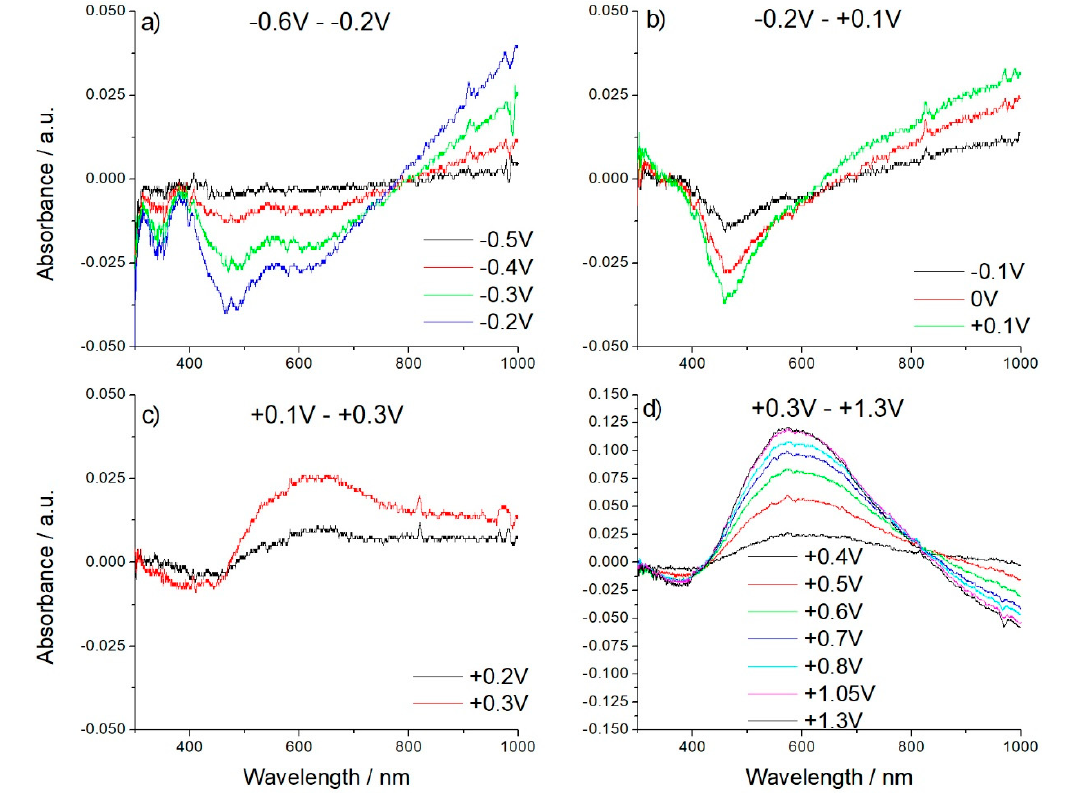
Figure 7. UV-vis-NIR spectra of a poly-[Co(Amben)]-modified ITO-coated glass electrode acquired during redox switching in 0.1 M Et 4 NBF 4 /EC/DEC: ( a ) spectra collected from − 0.6 to − 0.2 V, referenced to the spectrum of the polymer at − 0.6 V, ( b ) spectra collected from − 0.2 to +0.1 V, referenced to the spectrum of the polymer at − 0.2 V, ( c ) spectra collected from +0.1 to +0.3 V, referenced to the spectrum of the polymer at +0.1 V, ( d ) spectra collected from +0.3 to +1.3 V, referenced to the spectrum of the polymer at +0.3 V.